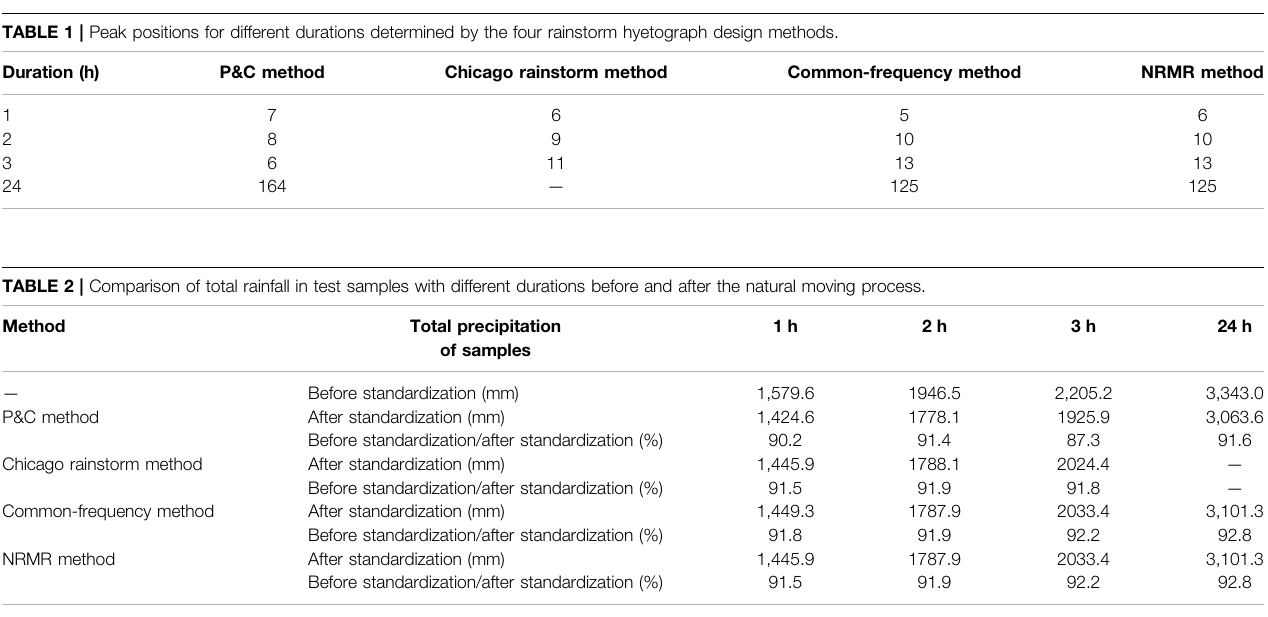
Common-frequency